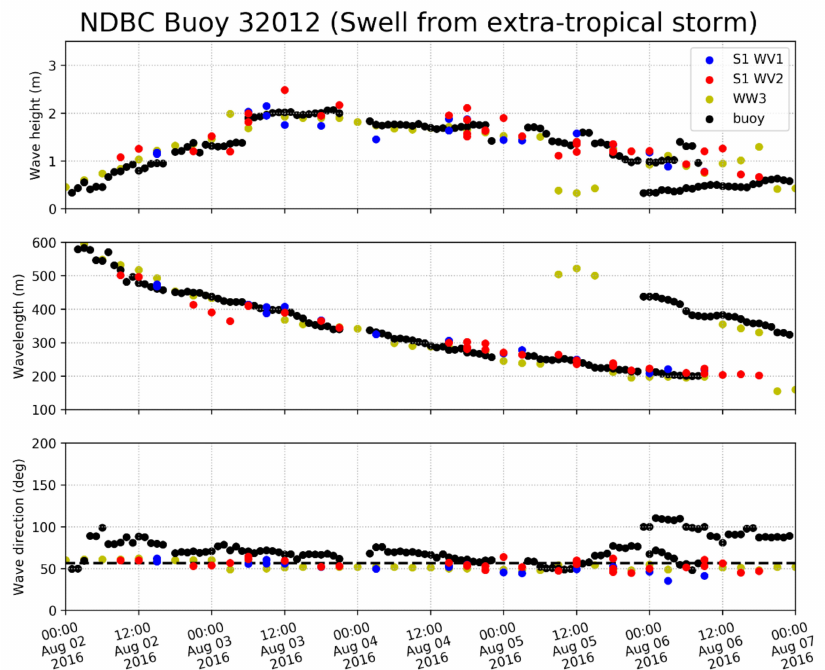
Figure 16. Comparison of significant wave height ( top ), peak wavelength ( middle ), and peak direction ( bottom ) from Level-3 CMEMS “fireworks” SAR products (red and blue dots representing Sentinel-1 SAR data in WV1 and WV2, respectively), buoy measurements (black dots) and WW3 model (yellow dots) at the Stratus buoy station #32012 (19.63 ◦ S/84.95 ◦ W) during the swell event generated by an extra-tropical storm on 28 July